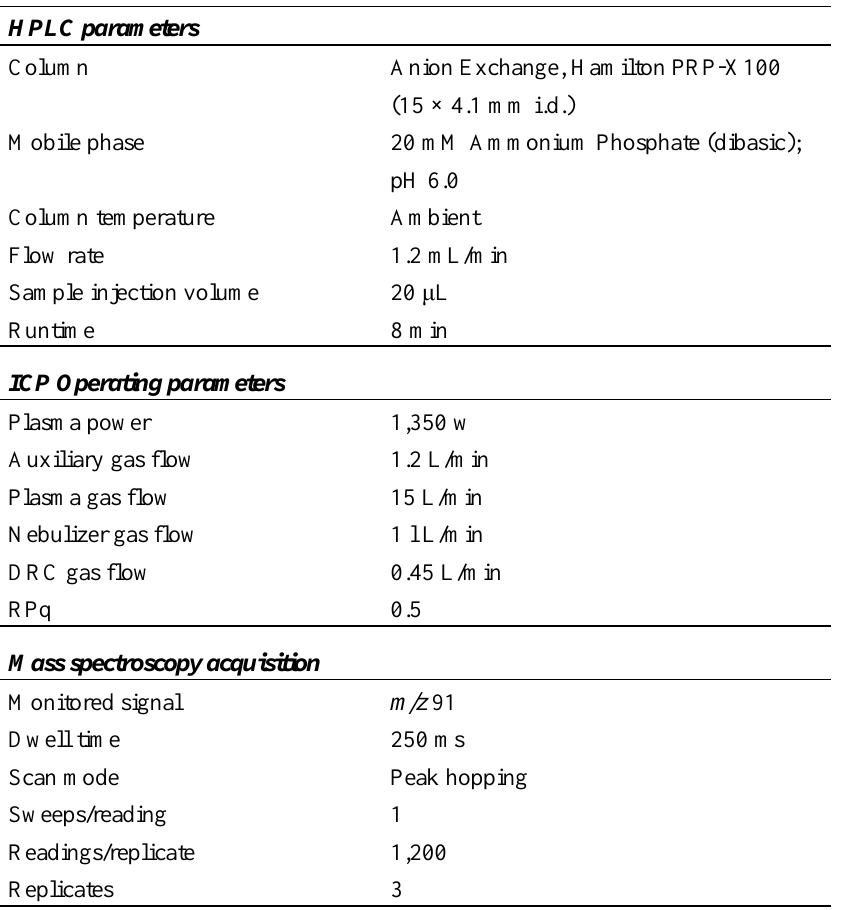
Table 1. Operating conditions of the HPLC-ICP-MS for arsenic speciation in